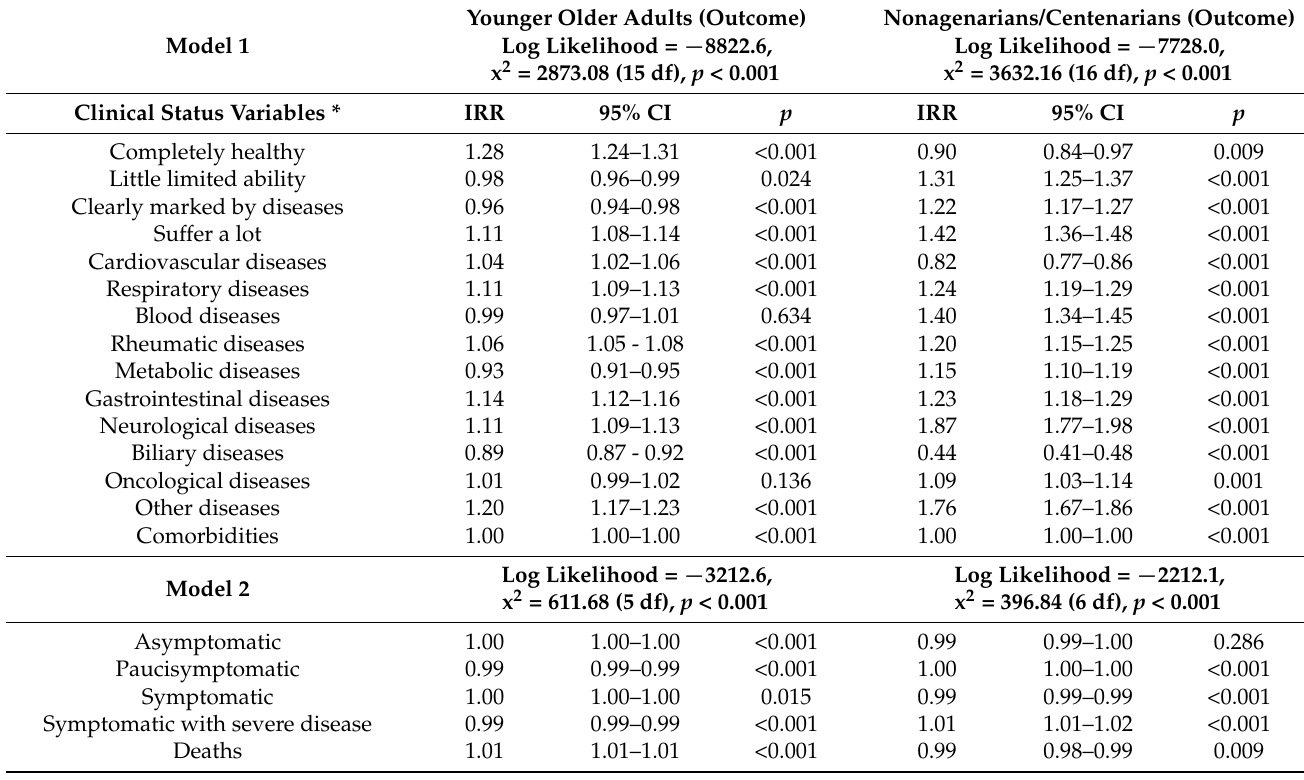
Table 1. Clinical status, respectively, of the younger older adults and the nonagenarians/centenarians.